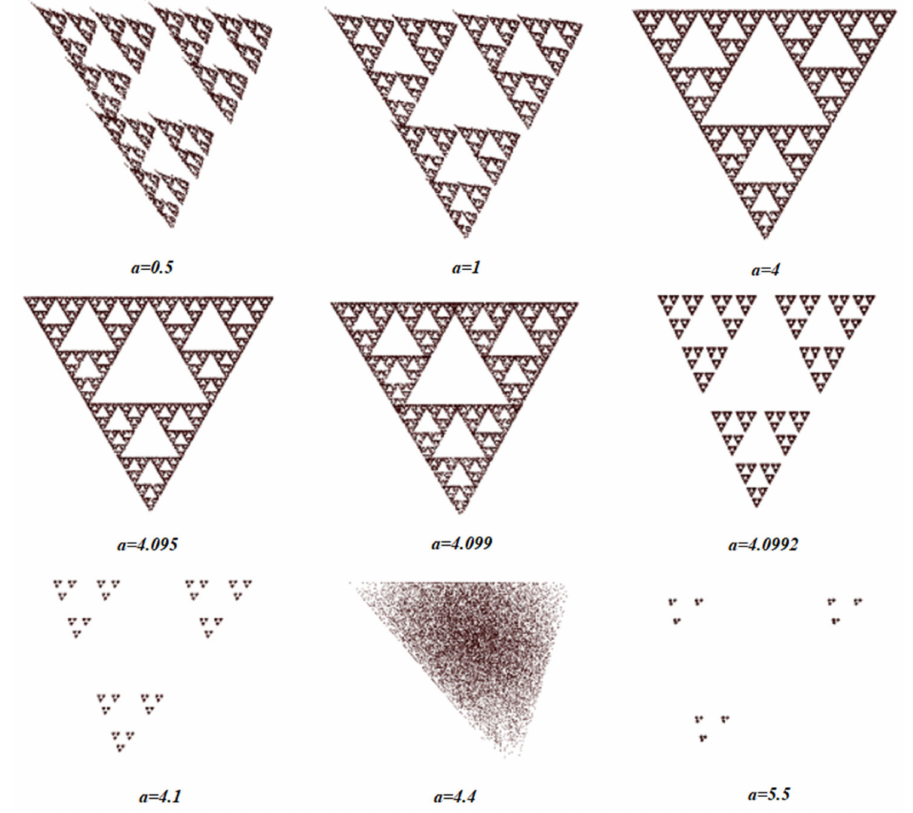
Figure 4. Some last images of fractal with first kind for the neural network with different growth